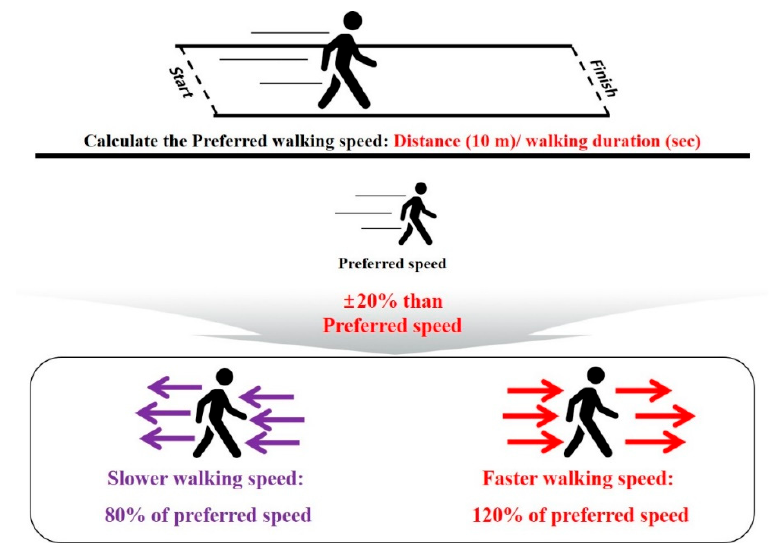
Figure 2. Walking speed definitions: slower (20% less than the preferred) and faster (20% more than the preferred) speeds, calculated based on the participant’s preferred speed.